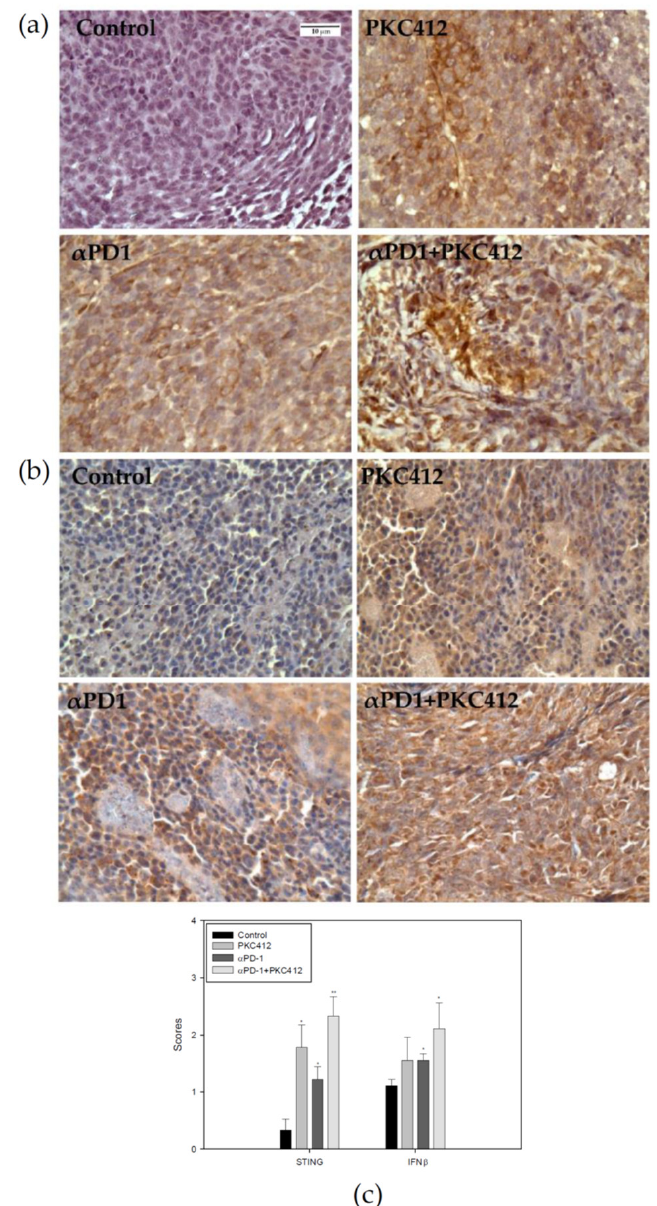
Figure 11. Expression levels of STING and IFN β in a CT26 syngeneic animal model after monotherapy or combination of midostaurin (PKC412) and anti-PD-1. At the end of the experiment, mice were sacrificed and tumor specimens were harvested for immunohistochemistry staining STING ( a ) and IFN β ( b ) protein expressions. The score of STING and IFN β protein expressions level in tumor ( c ) after tumor cells implanted in syngeneic BALB/c mice. Data from six mice of each group were expressed as mean ± SEM. Significant differences between control group and PKC412-treated group, or anti-PD-1-treated group and combination-treated group are indicated by * p < 0.05, ** p <